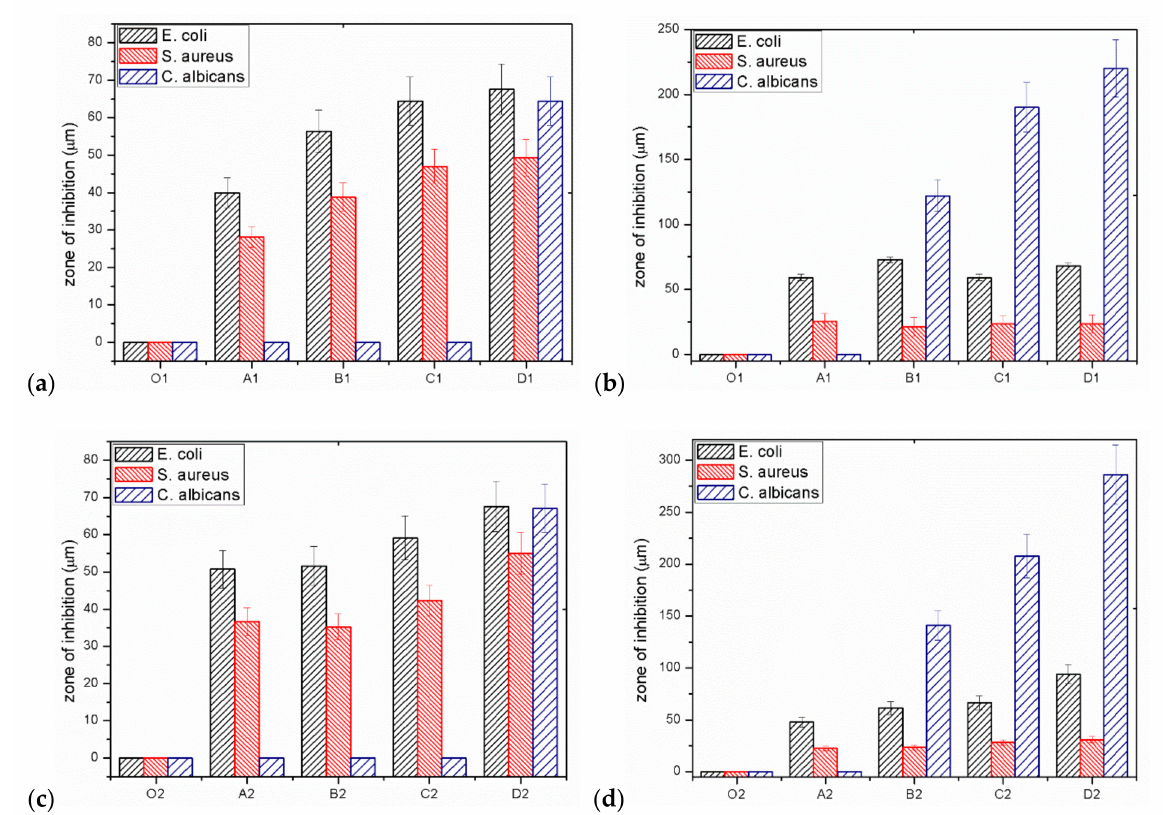
Figure 7. Results of the inhibition zone measurements for individual micro-organisms: ( a ) Whole fibres; ( b ) short sections of water coagulated fibres (1); ( c ) whole fibres; ( d ) short sections of fibres coagulated in methanol